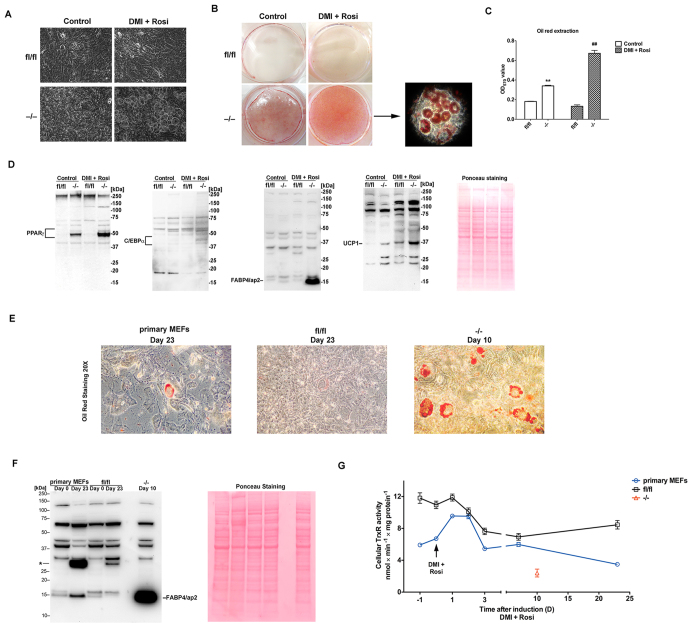
Txnrd1 depletion increases lipogenesis and promotes adipocyte differentiation of mouse embryonic fibroblasts.(A) MEFs were hormonally induced to trigger adipocyte differentiation (DMI + Rosi; see Methods for details) and on day 8, the cells were imaged with 20x magnification; left column are untreated controls at day 8, right column are hormonally induced cells. (B) The same cells as shown in A were stained with Oil Red-O and shown are photos of the entire petri dishes; The arrow points toward an image with 20x magnification displaying the Oil Red-O-stained adipocytes formed in Txnrd1−/− MEFs. (C) The Oil Red-O staining was extracted from plates as shown in B and the color intensity was measured (n = 4–8, ±SEM). Significant differences between Txnrd1fl/fl and Txnrd1−/− MEFs in the control samples are indicated (**P < 0.01) as well as in the hormonally treated samples (##P < 0.01). (D) The cell lysates of MEFs treated as in B were immunoblotted with antibodies against PPARγ, C/EBPα, FABP4/aP2 and UCP1. Positions of molecular weight markers (kDa) and the sizes of the analyzed proteins are as indicated. Ponceau S staining of the membrane was used as protein loading control (right). (E) The different MEFs were induced to adipocyte differentiation for the time indicated. Oil Red-O staining with 20x magnification was used to image the formed adipocytes. (F) The cell lysates of the MEFs in E were immunoblotted with antibody against FABP4/aP2, as indicated. The symbol “*” indicates an unidentified band approximately twice the size of FABP4/aP2. Ponceau S staining of the membrane was used as loading control (right). (G) Cellular TrxR activity in extracts of the indicated MEF cultures was measured at different time points during the adipocyte differentiation process. The arrow indicates the initiation of adipocyte differentiation using hormonal treatment.